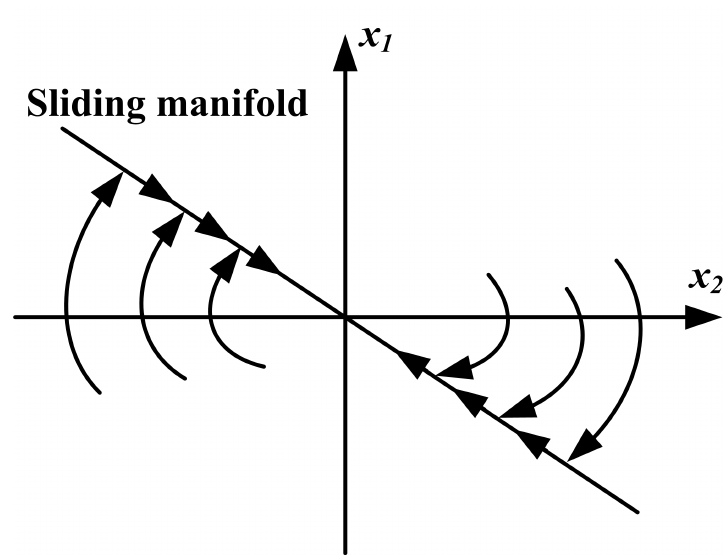
Figure 2. Sliding mode control (SMC) graphical representation of the sliding